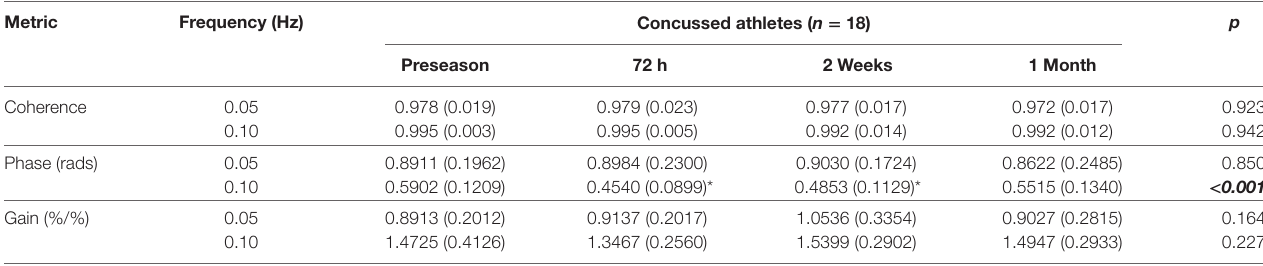
FigUre 2 | Normalized values of power spectrum densities for mean arterial pressure (MAP) (a,c ) and middle cerebral artery blood velocity (MCAv) (b,D) for preseason and post-concussion squat–stands at 0.05 (a,b) and 0.10 Hz (c,D) ; preseason squat–stands in subjects with zero vs. three or more previous concussions (e,F) . The frequency at which PSD reached a peak amplitude (either 0.05 or 0.10 Hz) was used for sampling point estimates for Coherence , Phase , and Gain .